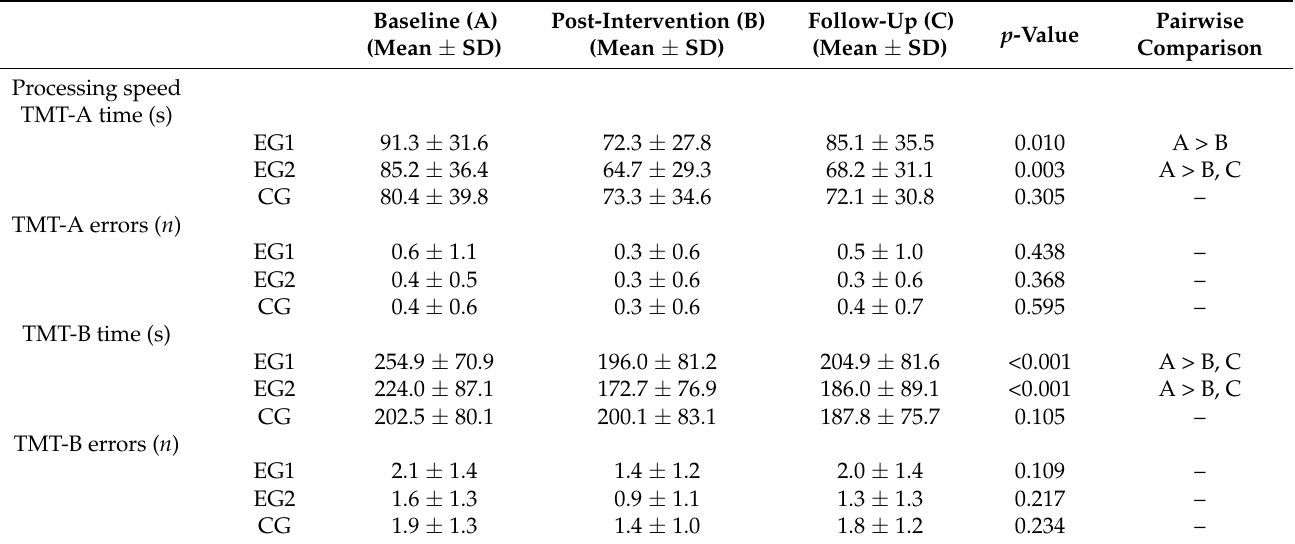
Table 4. Impact of the interactive cognitive–motor programs on processing speed